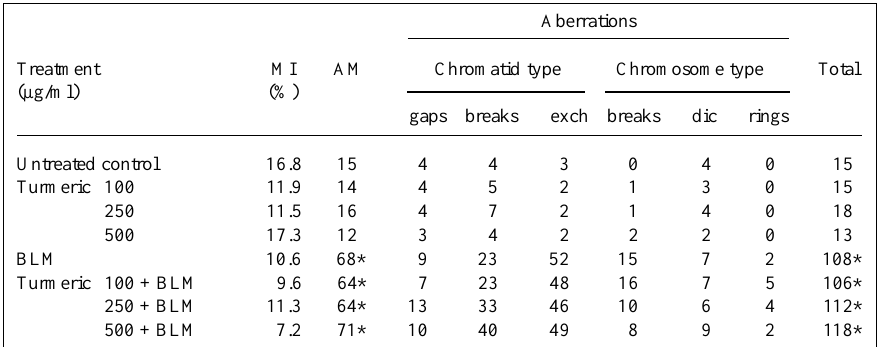
For symbols and abbreviations see Table I.